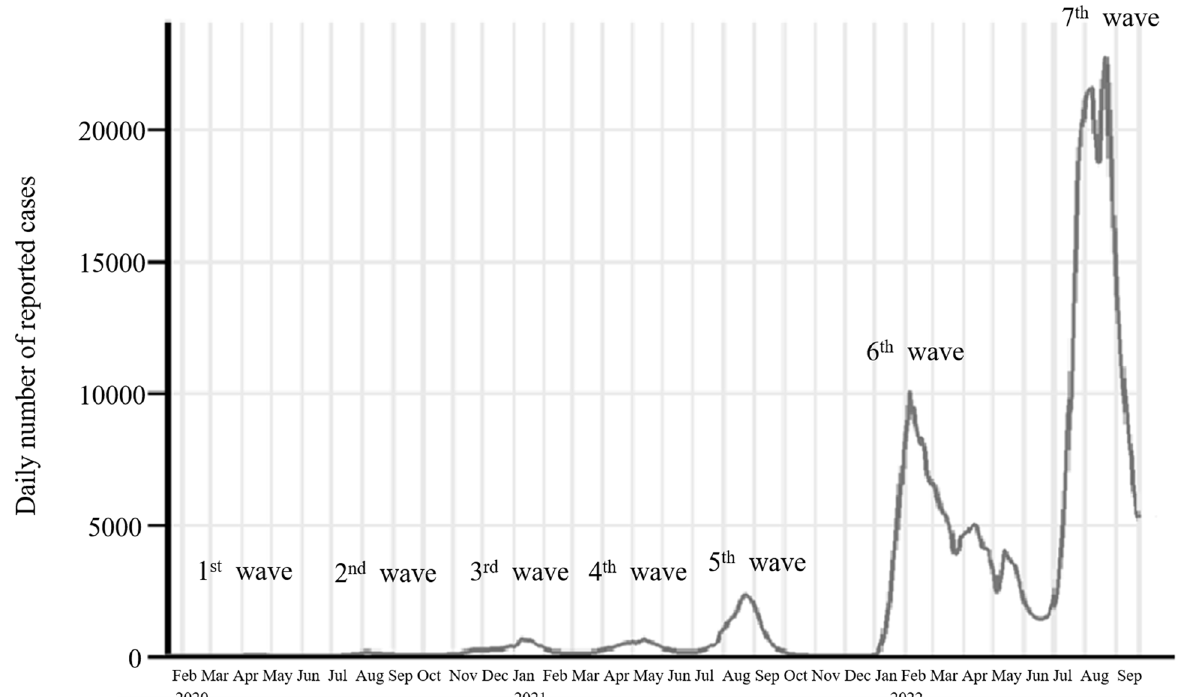
Fig. 2 Trends in the daily number of COVID-19 cases reported in Japan. The number of COVID-19 cases has increased remarkably in the 5th, 6th, and 7th waves. Chart elaborated at https:// www. ianca mpbell. co. uk/ covid- 19. php with data from johns Hopkins university. Last accessed